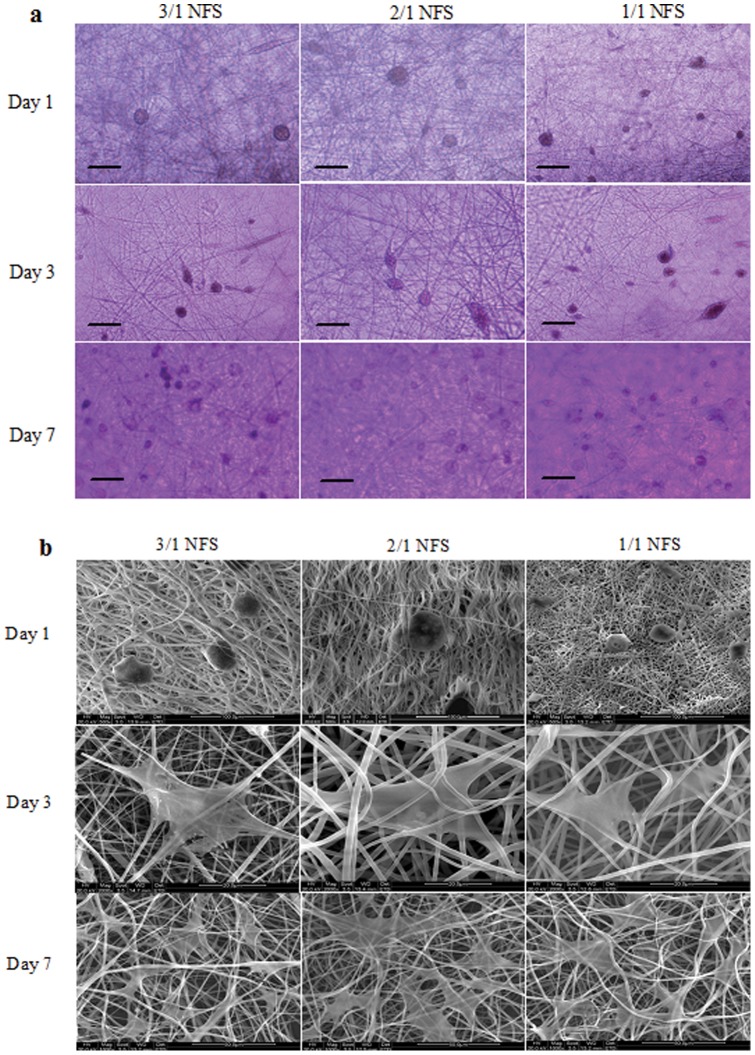
The morphology of hASCs on different NFS: (a) under light microscopy.Scale bar  = 100 μm; (b) under SEM. Scale bar  = 50 μm. Both in (a) and (b), the hASCs showed round spots because they released from culture flasks by trypsin on day 1 after seeding in NFS. On day 3, the hASCs extend their bodies attaching on the NFS fibers and proliferated in the nanofibrous space. Seen in (a), on day 7, the number of hASCs increased in all 3 NFS. In (b), the hASCs showed like white film in irregular shape attaching on the fibers around and grew in number from day 3 to 7.